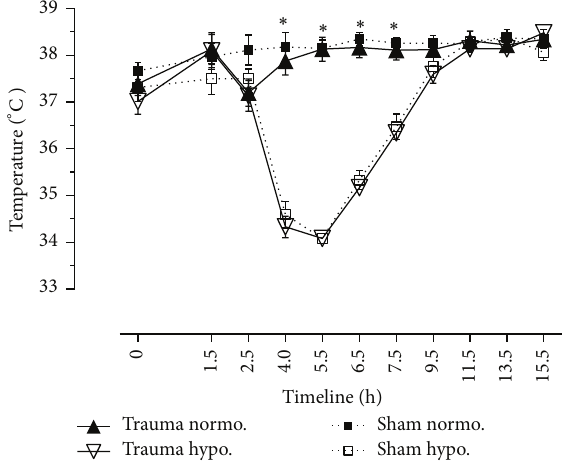
Figure 1: Temperature (in ∘ C). Temperature measured by rectal tube. Normothermic and hypothermic sham animals versus nor- mothermic and hypothermic trauma animals. 𝑁 = 40 . Timeline 15.5 hrs. Data are shown in mean and standard error of mean. ∗ 𝑃 < 0.05 , normothermic versus hypothermic pigs during cooling phase (4, 5.5, 6.5, and